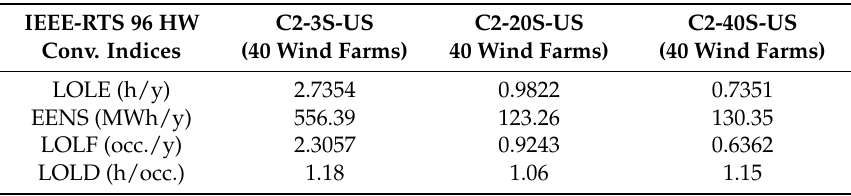
Table 7. Operating reserve-IEEE-RTS 96 HW increasing